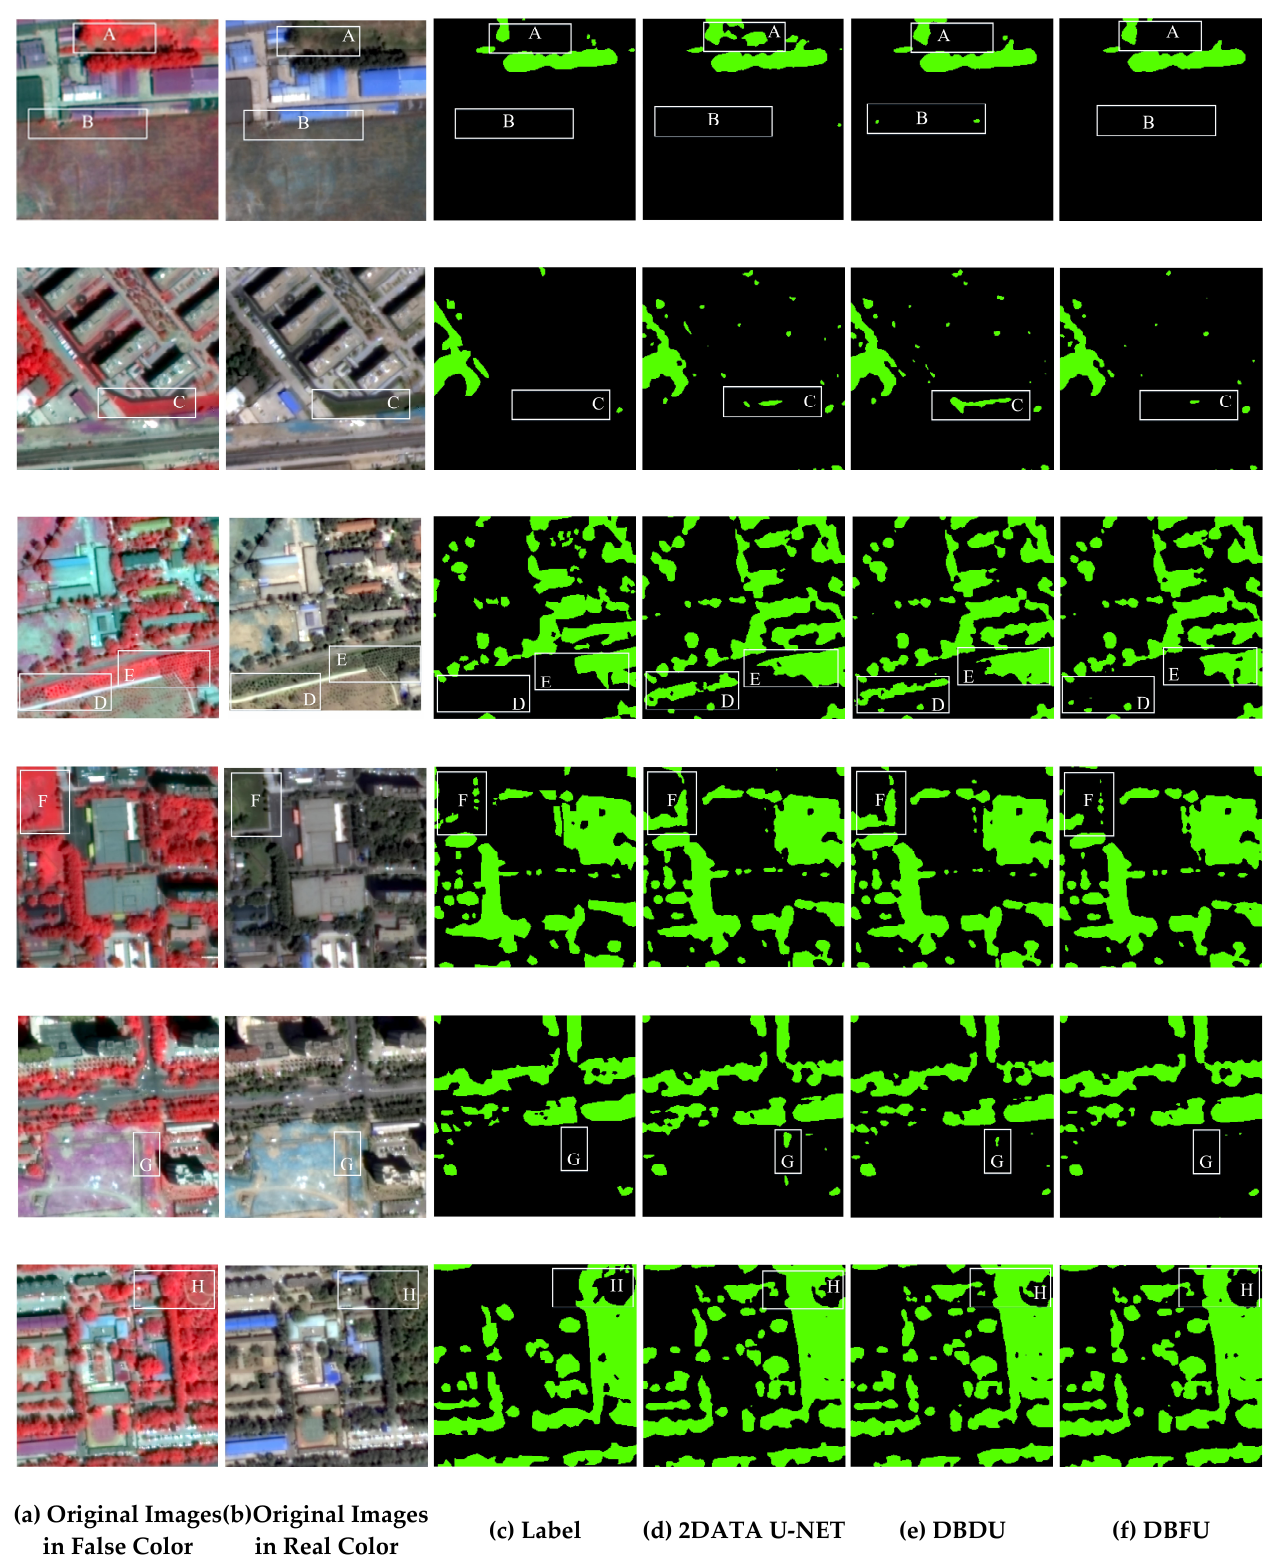
Figure 14. Comparison of classification results of 2DATA U-NET, DBDU, DBFU: ( a ) original images in false color, ( b ) original images in real color, ( c ) ground truth, ( d ) classification results of 2DATA U-NET, ( e ) classification results of DBDU, ( f ) classification results of